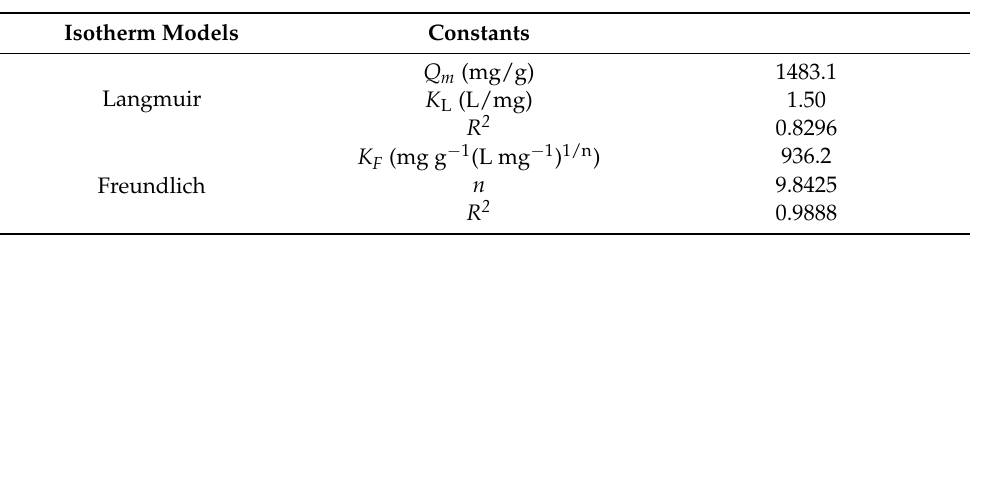
Table 3. Fitting parameters of the Langmuir, Freundlich and Temkin isotherm models at 303